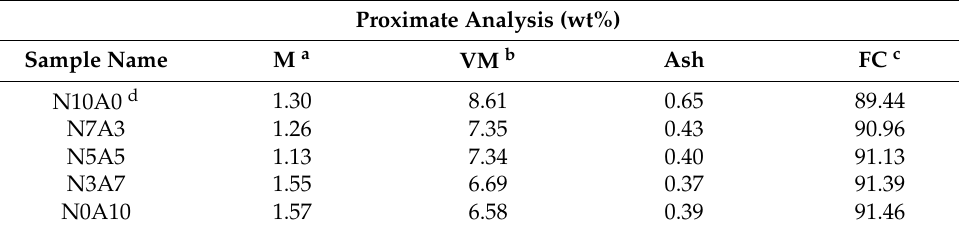
Table 3. Proximate analysis of binderless cokes manufactured according to flow ratio of nitrogen and